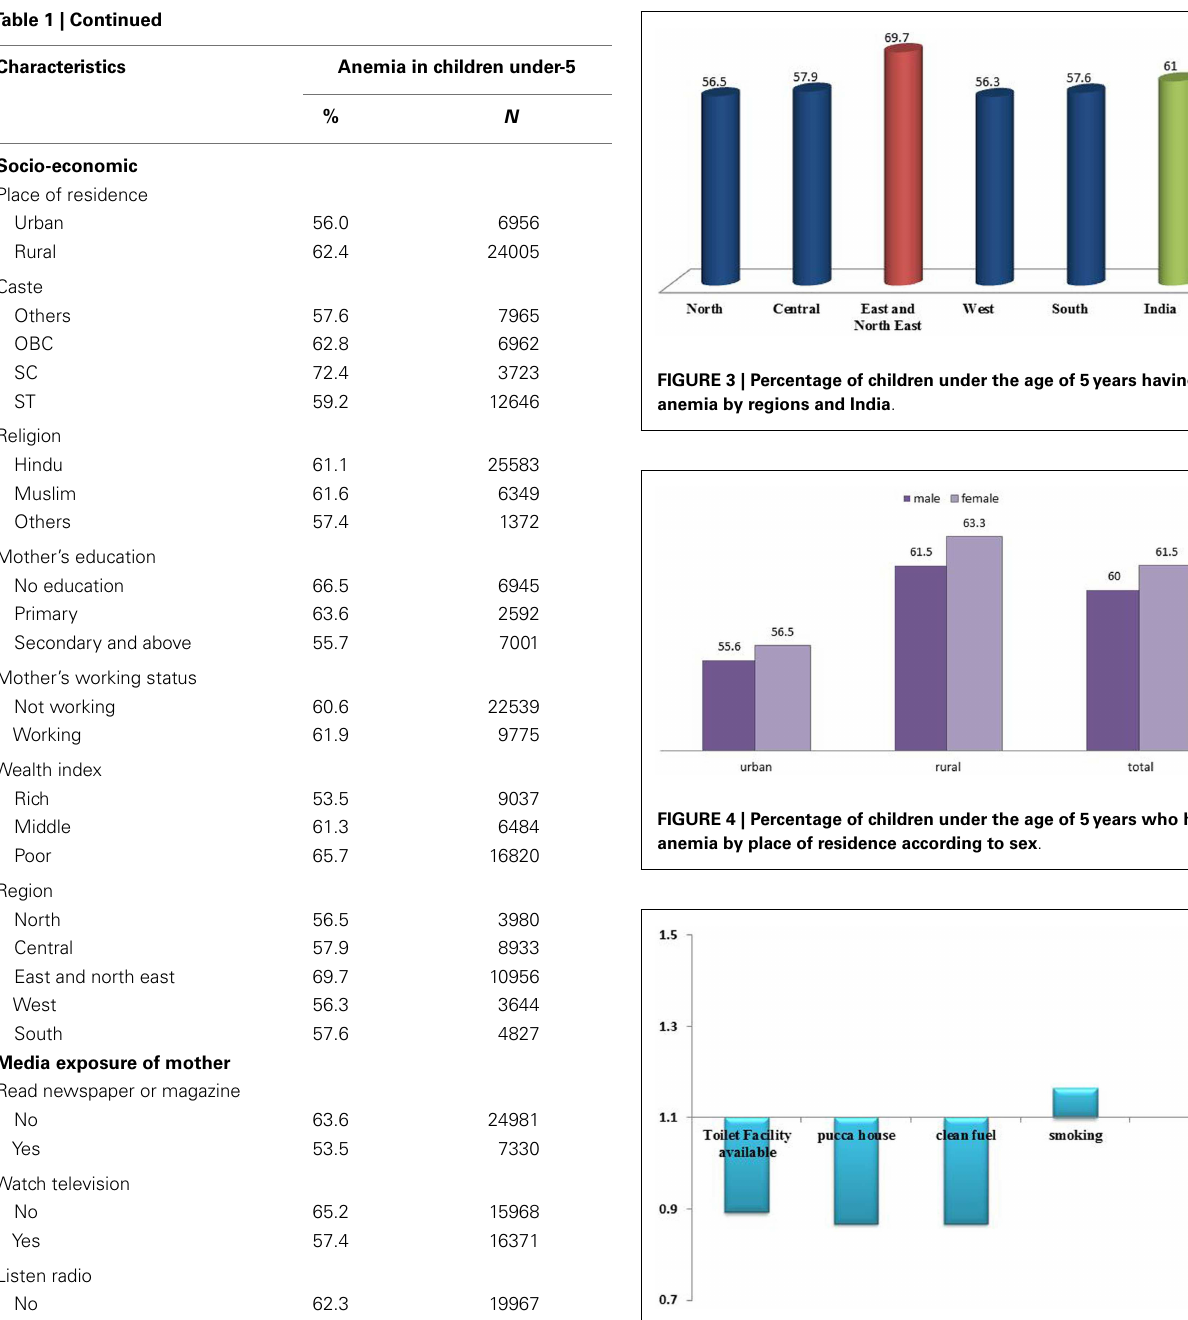
FIGURE 5 | Significant odds of suffering anemia by major household environment determinant